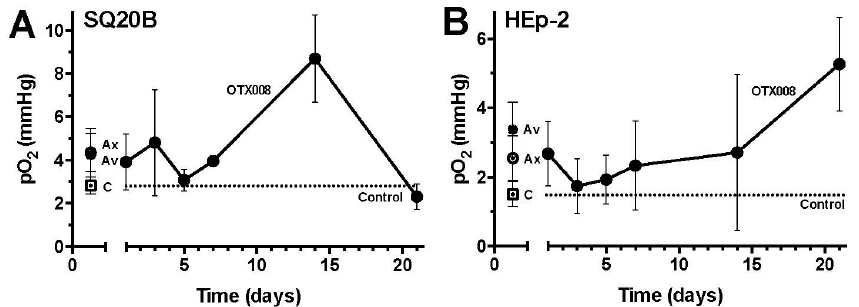
Figure 1. The effect of OTX008 on global tumor pO 2 over time. Global tumor pO 2 is transiently increased by OTX008 in SQ20B ( A ) and HEP2 ( B ) tumors as measured by fiber-optic oxygen sensor. Treatments: Control (C; - -), OTX008 (- -), Anginex (Ax; - -), and Avastin (Av; - -). Points, average mean (± SEM) pO 2 value derived from the stabilized reading over a 60 s period at one location (four to seven mice per day per experimental group). The dotted line represents the average pO 2 mean of the control.